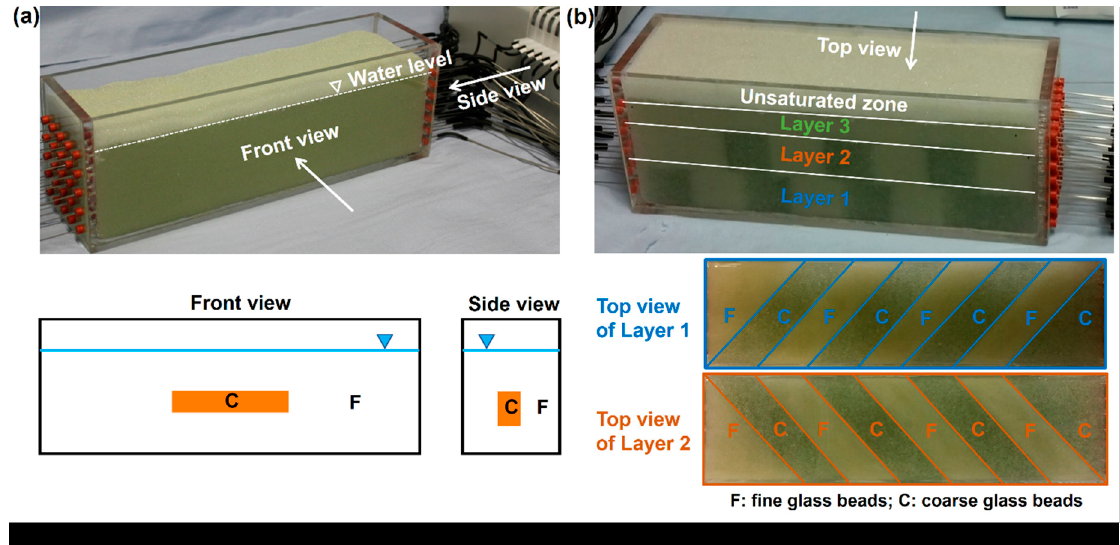
Figure 3. ( a ) Heterogeneous isotropic porous media setup: three-dimensional overview, front view and side view. The orange cube represents the high-permeability inclusion with coarse glass beads, and the other porous media consist of fine glass beads (modified from [81]). ( b ) Macroscopic heterogeneous anisotropic porous media setup: three-dimensional overview and top view of Layer 1 and Layer 2. Layer 1 and Layer 2 are structured as simplified herringbone cross-stratification with alternated fine and coarse glass beads, Layer 3 and the unsaturated zone consist of fine glass beads (modified from [80] and [82]).